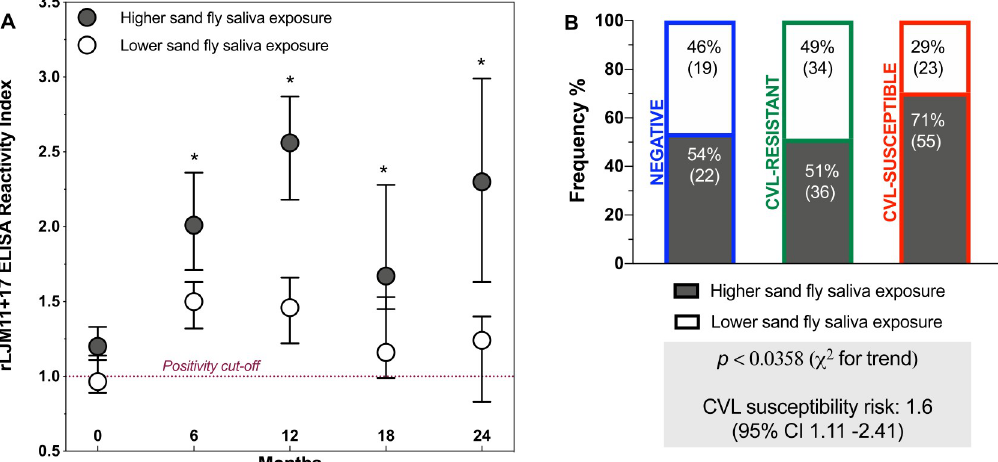
Fig 7. Anti-saliva antibodies levels. ( A ) rLJM11+17 ELISA reactivity index (RI) during the follow-up period; dots represent median RI; bars represent 95% confidence interval (CI) of the median, asterisks indicate significant differences between higher and lower anti-saliva antibody levels (p < 0.05, Kruskal-Wallis and Dunn tests). ( B ) Frequencies of negative, CVL-resistant, and susceptible dogs stratified by levels of anti-saliva antibodies; chi-square test for trend ( x 2 ) analysis and relative risk (RR) with 95% CI calculated to assess the risk of CVL